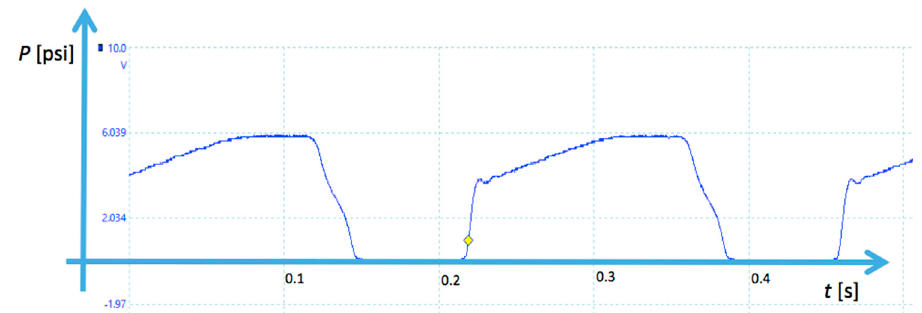
Figure 7. Example of pressure pulses registered by oscilloscope.